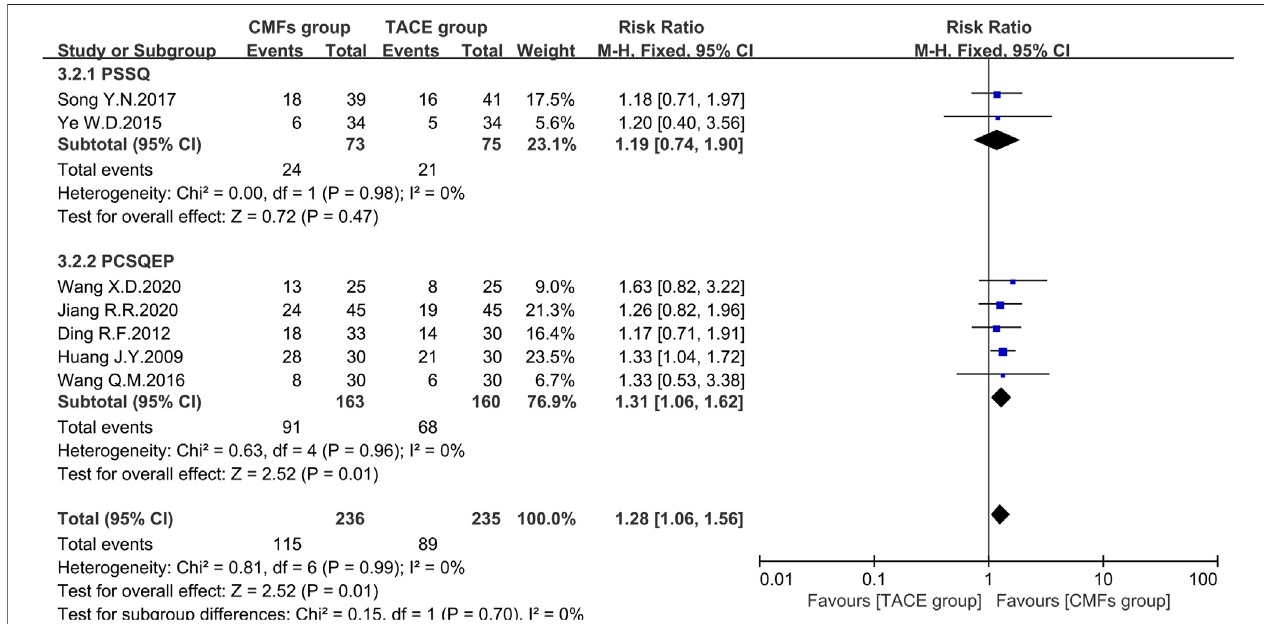
FIGURE7 | Effect of CMFs group versusTACE group on ORR applied the RECIST criteria, including acomparison between PSSQand PCSQEP in the subgroup.